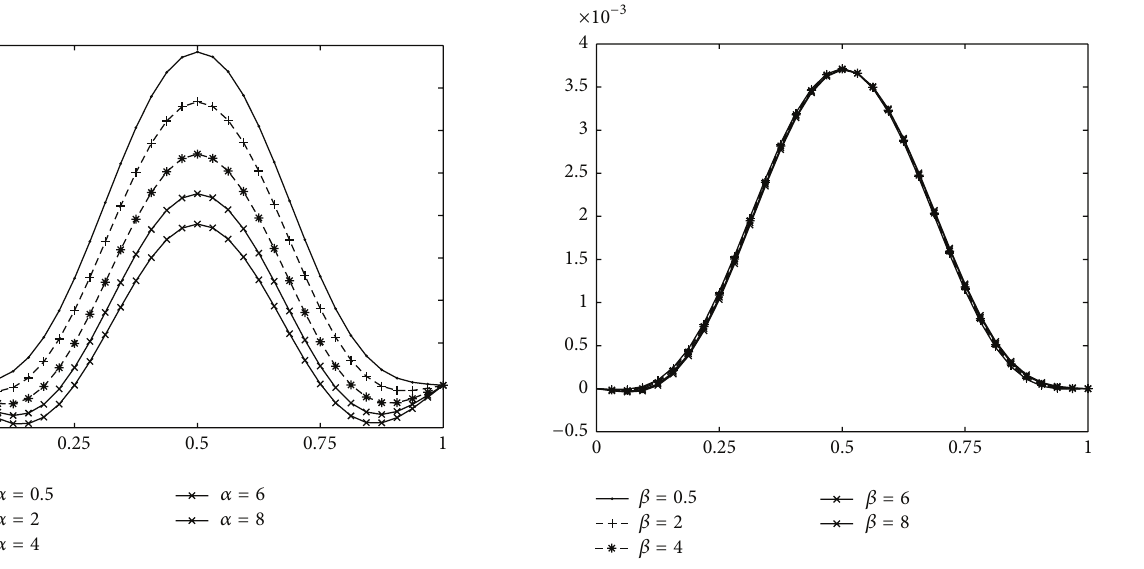
Figure 12: Numerical solutions at different 𝛽 with ℎ = 1/32 , 𝜏 = 0.1 , 𝛼 = 1 , and 𝑝 = 8 .